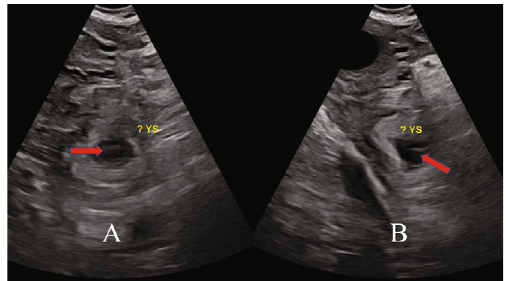
Figure 3: Longitudinal (a) and transverse (b) transvaginal ultrasound images of the right adnexa structure demonstrate possible internal echogenicity or septations (red arrow) which may represent a yolk sac or reverberation artifact.